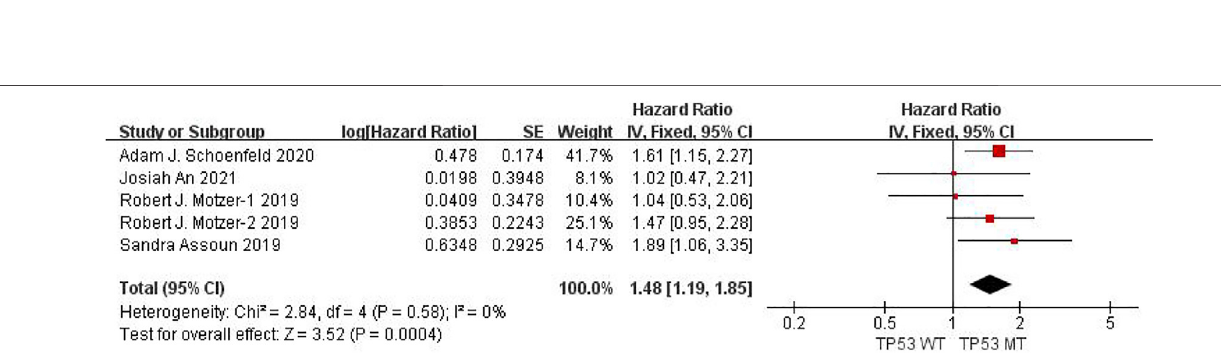
FIGURE 4 | Meta-analysis of objective responses according to TP53 status of PFS in cancer patients treated with ICIs.